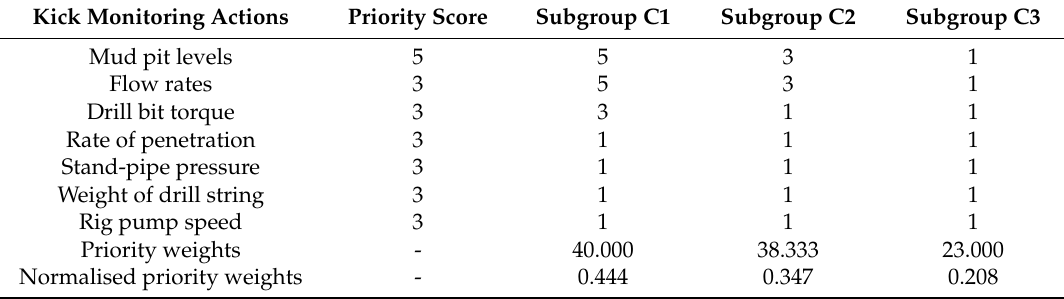
Table 4. Evaluation of the house of quality 1 (HoQ 1) relationship matrix in a case study when scores represent triangle